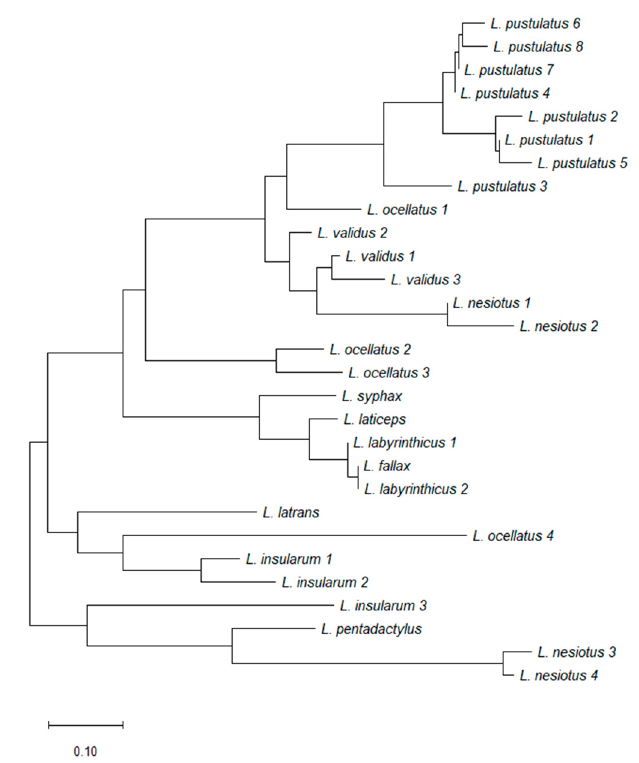
Figure 4. Sequence alignment of the ocellatin peptides from L. insularum and L. nesiotus with the orthologous peptides from other Leptodactylus species isolated to ‐ date. Gaps denoted by (*) are introduced into certain sequences in order to maximize the structural similarity of the peptides. Shading is used to indicate the amino acid residues that have been very strongly conserved. a Denotes C ‐ terminal α‐ amidation.